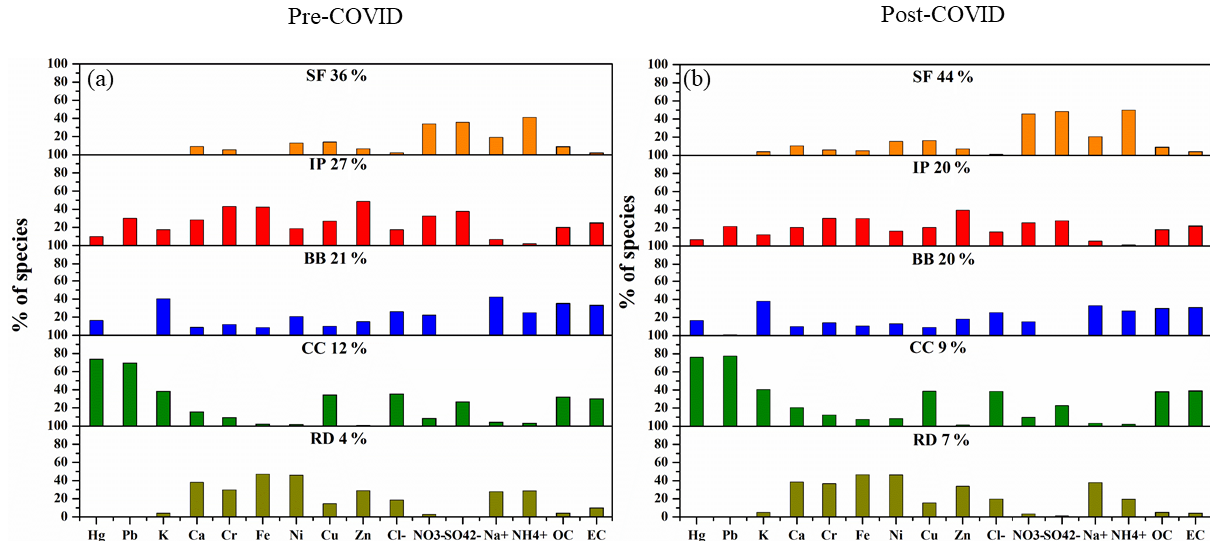
Figure 11. The comparison of source apportionment for PM 2 . 5 chemical compositions before (a) and after (b) the COVID-19 outbreak. In our study, five major sources were distinguished based on the PMF model. The color bar denotes the contributions of these sources to each species. SF, IP, BB, CC, and RD represent secondary formation, industrial process, biomass burning, coal combustion, and road dust,